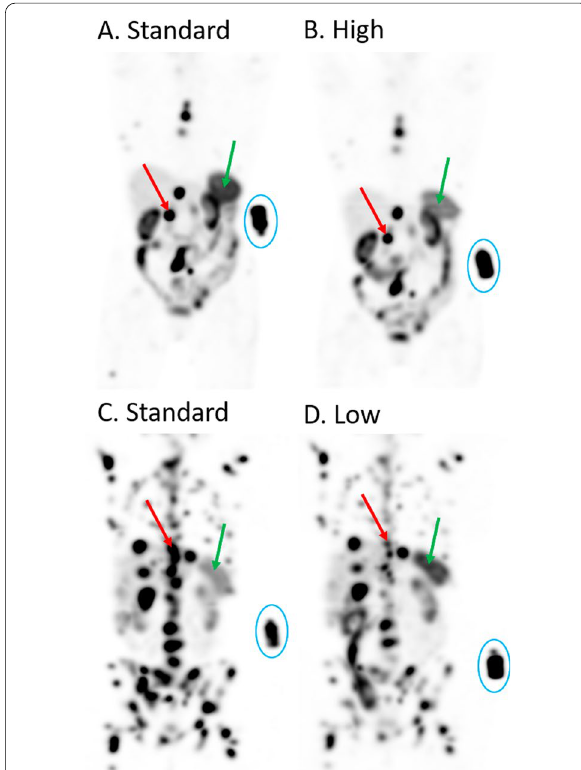
Fig. 3 Maximum intensity projections of SPECT images acquired 24 h after injection of [ 177 Lu]Lu‑HA‑DOTATATE. ( A , B ) Patient with both standard (cycle 2) and high (cycle 1) peptide amount. ( C , D ) Patient with both standard (cycle 1) and low (cycle 2) peptide amount. Green arrows indicate the spleen, which shows decreased uptake with high peptide amount and increased uptake with low peptide amount. Red arrows point to tumor lesions, which show decreased uptake in both high and low peptide amounts. A reference standard with known amount of radioactivity is scanned with each patient (encircled in